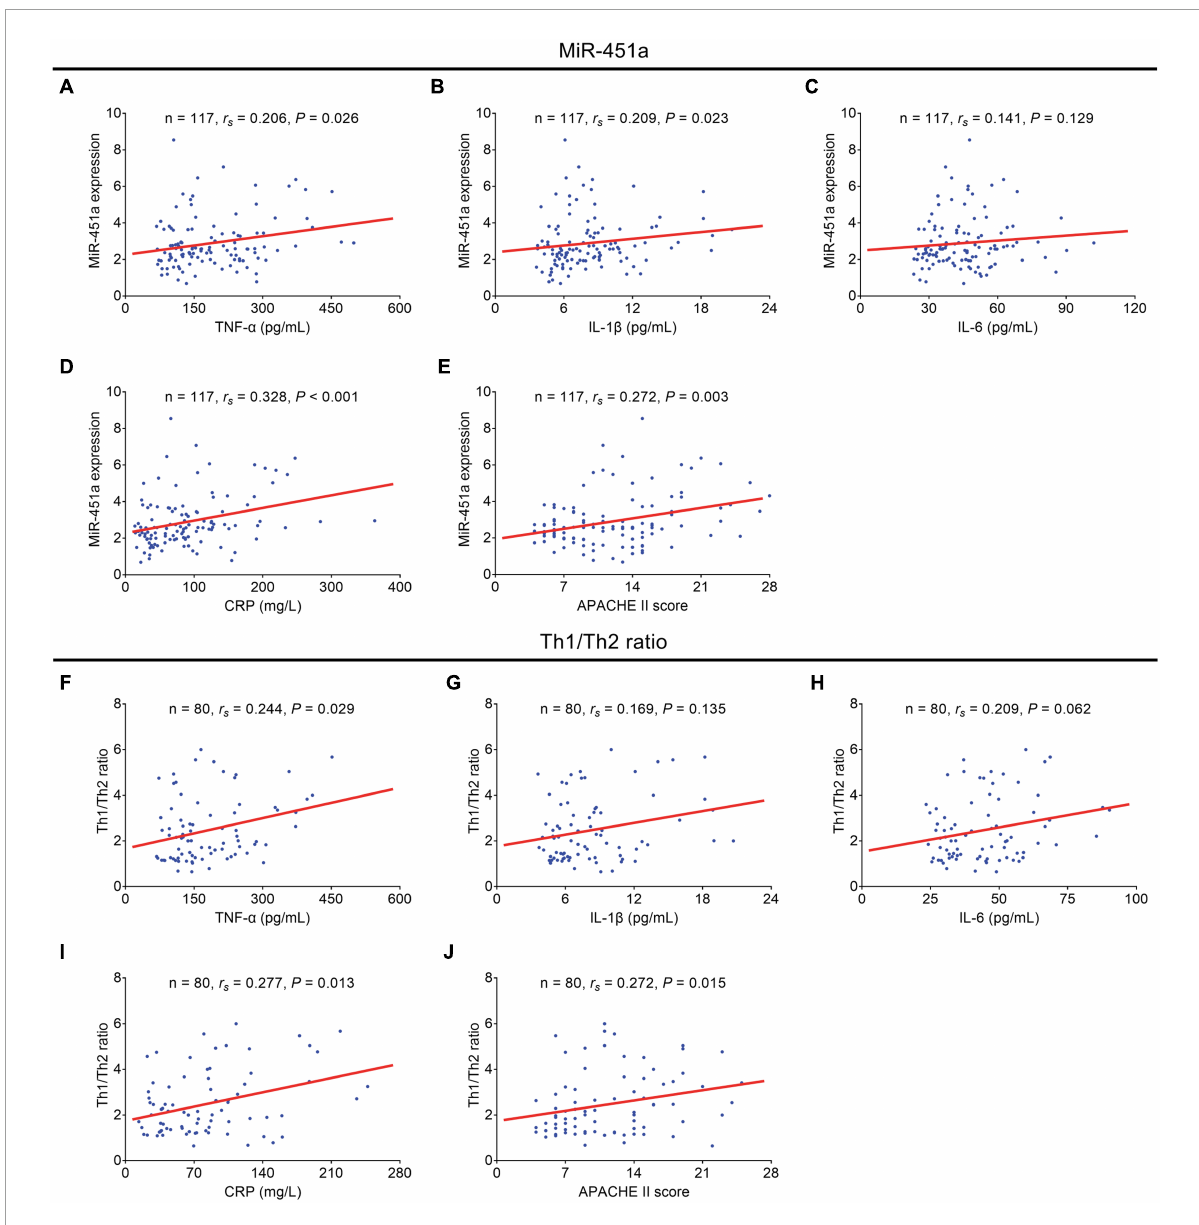
FIGURE3 MiR-451a and the Th1/Th2 ratio were positively correlated with inflammatory cytokines and the APACHE II score. Correlation of miR-451a with TNF- α (A) , IL-1 β (B) , IL-6 (C) , CRP (D) , and the APACHE II score (E) in patients with sepsis. Correlation of the Th1/Th2 ratio with TNF- α (F) , IL-1 β (G) , IL-6 (H) , CRP (I) , and the APACHE II score (J) in patients with